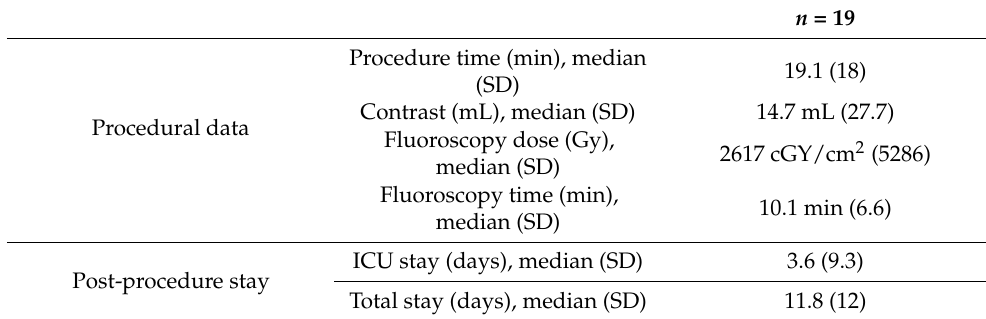
Table 3. Procedural data and postintervention stay. ICU: intensive care unit, SD: standard deviation.